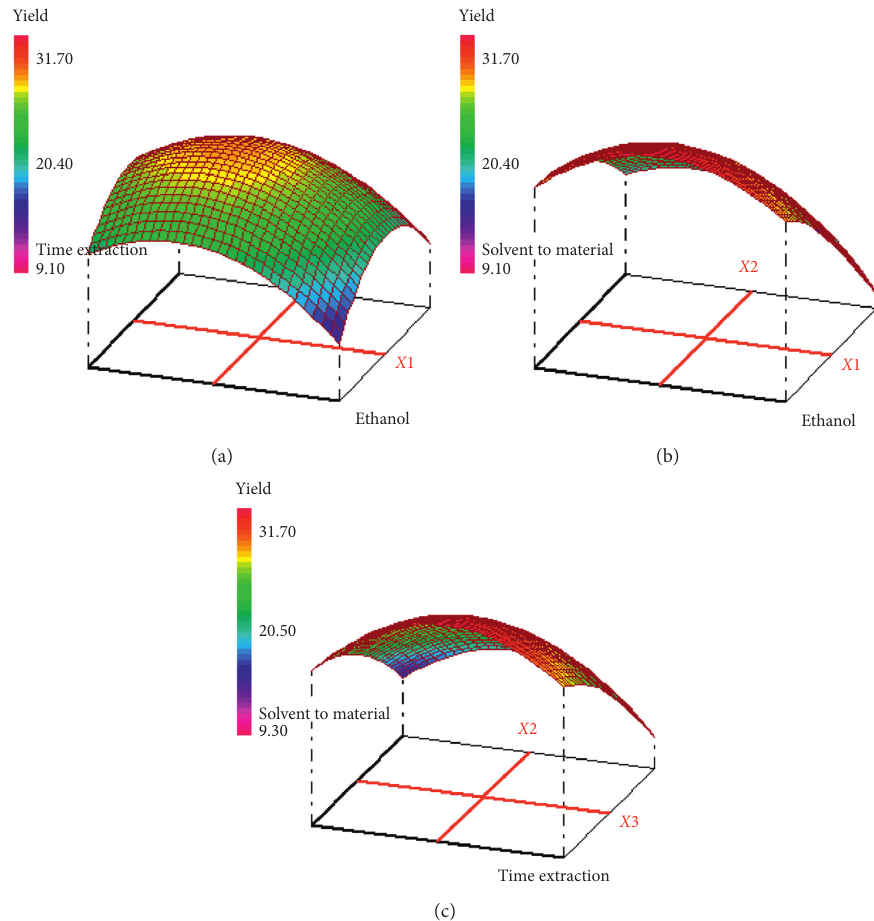
Figure 6: Response surface for the effect of independent variables on extraction yield. (a) Response surface graph showing interaction between extraction time ( X 3) and ethanol concentration ( X 1); (b) response surface graph showing interaction between solvent-to-material ratio ( X 2) and ethanol concentration ( X 1); (c) response surface graph showing interaction between extraction time ( X 3) and solvent-to- material ratio ( X